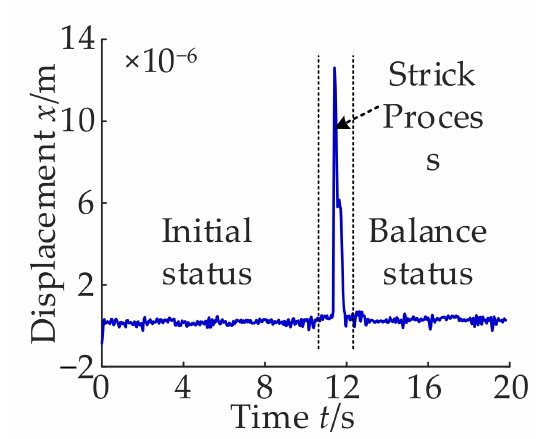
Figure 17. Displacement of rotor by test when K p = − 70.